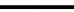
 30 Brown et al., Language Models are Few - Shot Learners